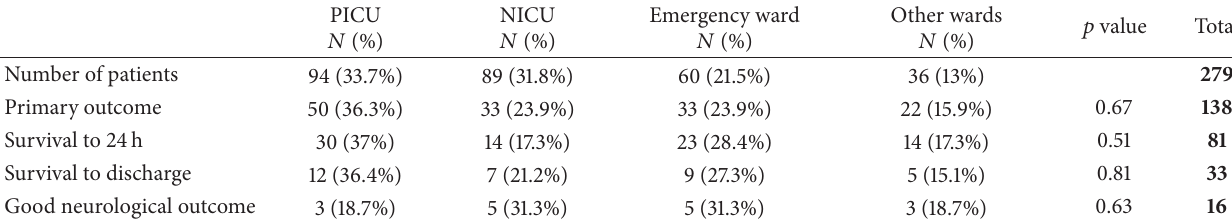
Table 1: Location of occurrence of